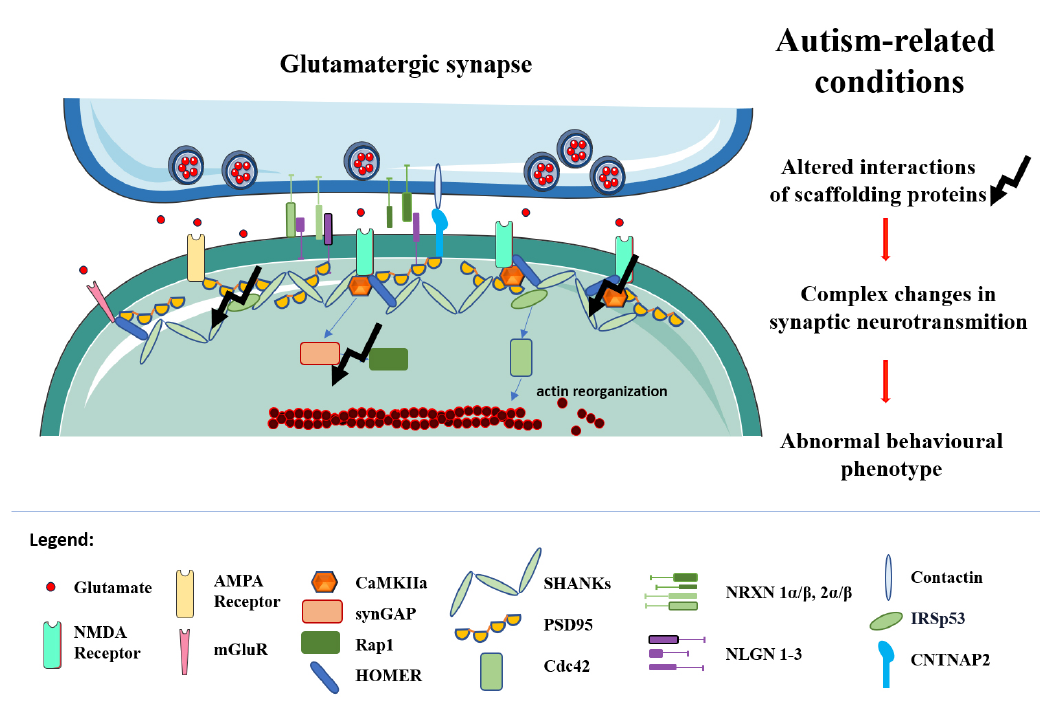
Fig. 1. Schematic representation of glutamatergic synapse, showing altered interactions (thunderbolt sign) of scaffolding proteins at the postsynaptic density observed in autism-like animal models. α -amino-3-hydroxy-5-methyl-4-isoxazolepropionic acid receptor (AMPA) receptor, Calmodulin-dependent protein kinase II-alpha (CaMKII α ), Cell division control protein 42 (Cdc42), contactin-associated protein-like 2 (CNTNAP2), In- sulin receptor substrate p53 (IRSp53), N -methyl- D -aspartate receptor (NMDA) receptor, metabotropic glutamate receptor 1 and 5 (mGluR), Postsynaptic density protein 95 (PSD-95), Neurexins (NRXNs), Neuroligins (NLGNs), synaptic Ras GTPase-activating protein (synGAP), Ras-proximate-1 or Ras-related protein 1 (Rap1), SH3 domain and ankyrin repeat containing proteins